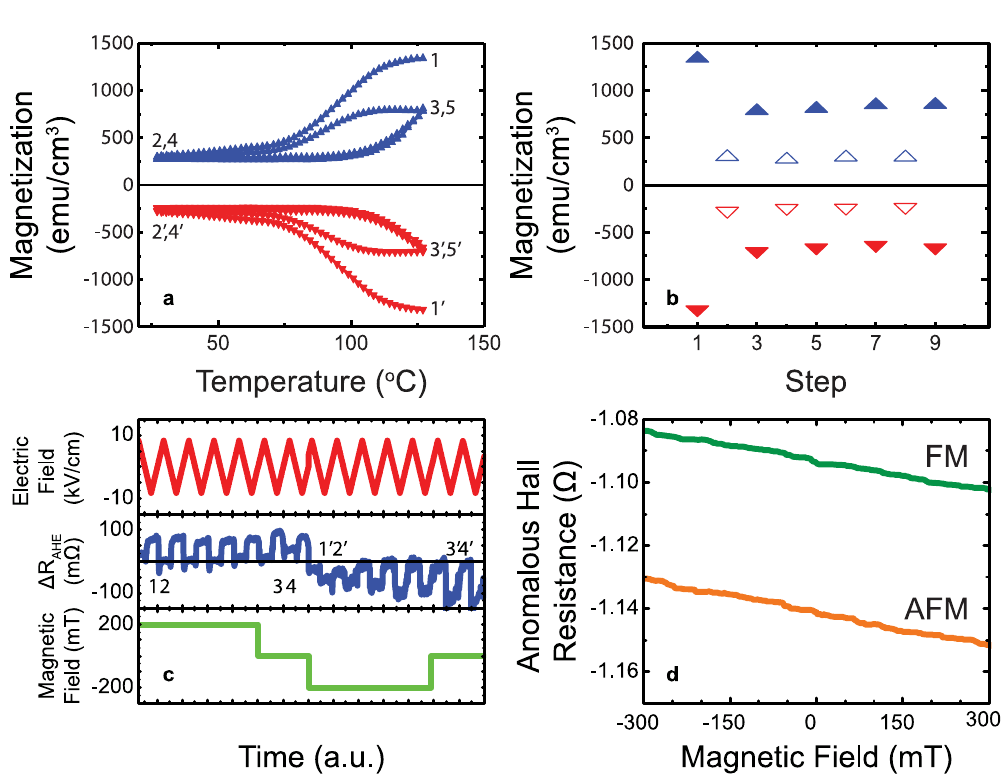
Figure 3. Phase Modulation and Invisible Memory Proof of Concept ( a ) Magnetization versus temperature loops measured at 0 mT, after saturating the sample ( ± 500 mT) at 127 °C. Arrows indicate increasing or decreasing temperature. ( b ) Magnetic moment at 127 °C (solid symbols) and 27 °C (open symbols) measured after successive thermal cycling at 0 mT. ( c ) Anomalous Hall resistance as a function of time (at 60 °C) at positive (200 mT), zero, and negative ( − 200 mT) magnetic fields through a series of different voltage cycles. Between the 0 and − 200 mT fields, a field cooling was carried out. ( d ) AHR as a function of magnetic field for the two 0 electric-field states at 25 °C. The magnetic response is due to the ordinary Hall effect, and are separated due to differing magnetization states, AFM and